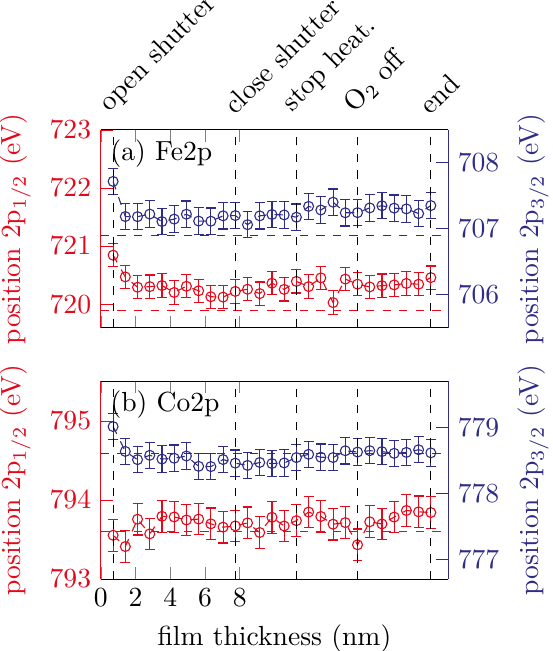
Figure 3. Peak positions of the ( a ) Fe 2p and ( b ) Co 2p peaks for sample A. The horizontal dashed lines represent the respective literature values for metallic Fe and Co.